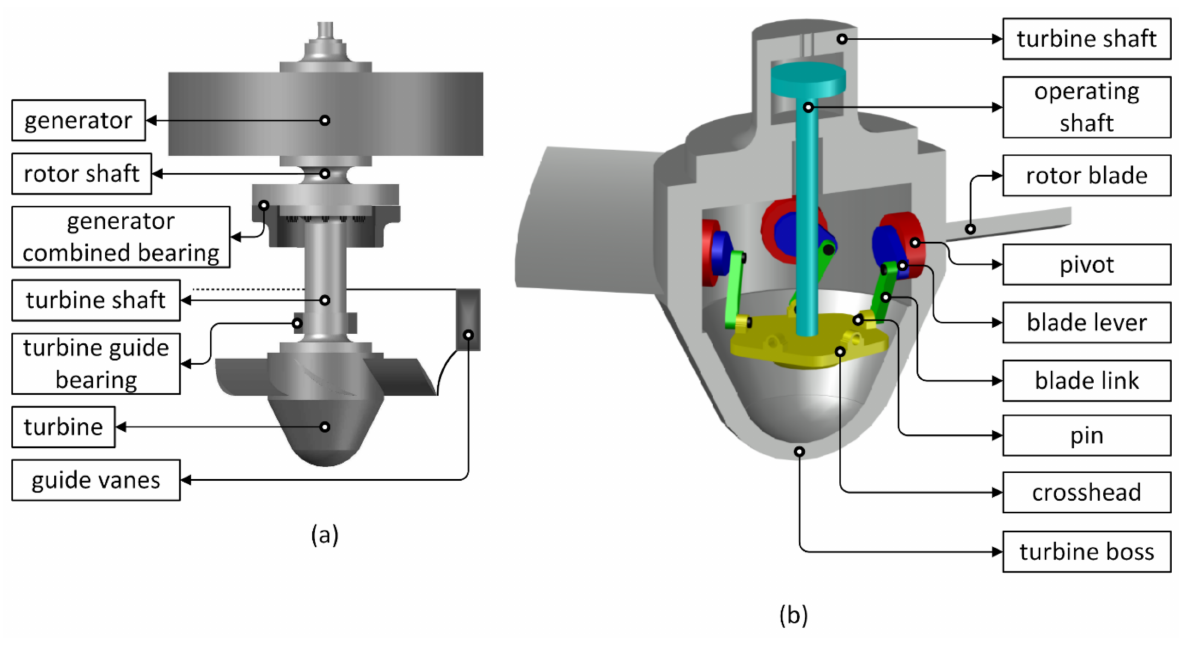
Figure 1. Hydrogenerator overview ( a ) and Kaplan turbine mechanism components ( b ).